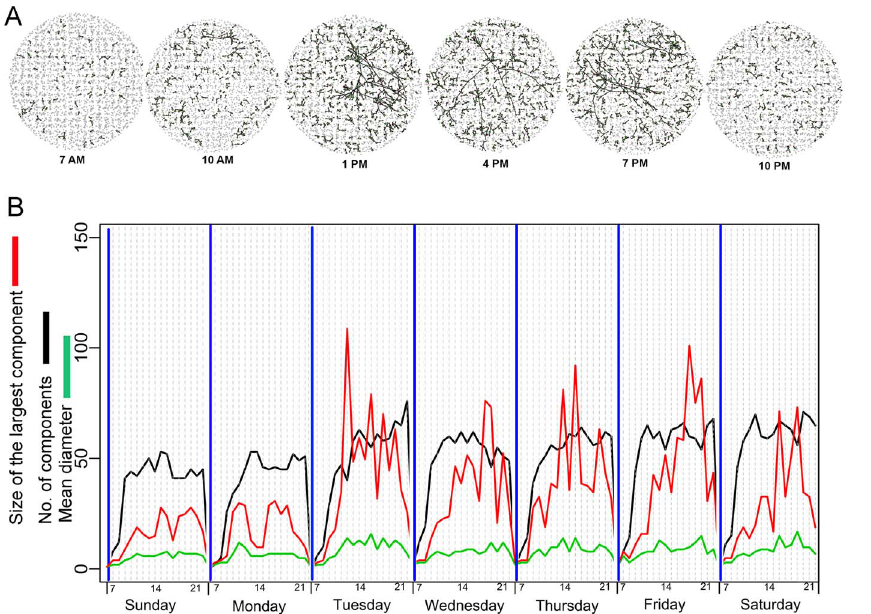
Figure 3. Dynamic mobility networks inferred from GPS data-logger data. (A) Time-varying bipartite graphs ( N ij (t) ) showing the variability in the connectivity in space and time among individuals during a typical day (e.g., Tuesday). (B) Time-series of different topological descriptors applied to N P (t) . As GPS units were turned off from 11:00 PM to 6AM we excluded this time period from the figure.